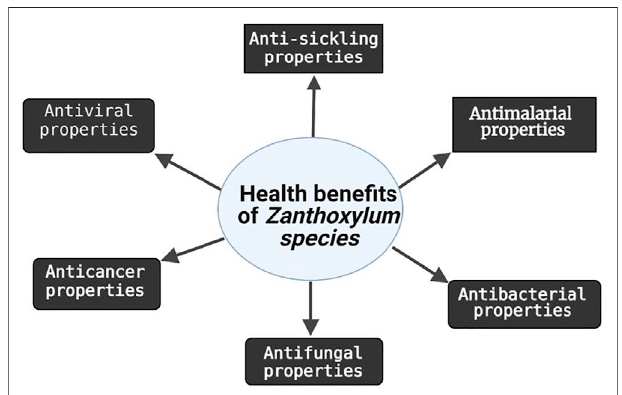
FIGURE 3 | Summary of biological activities of extracts or compounds from different parts of Zanthoxylum species.